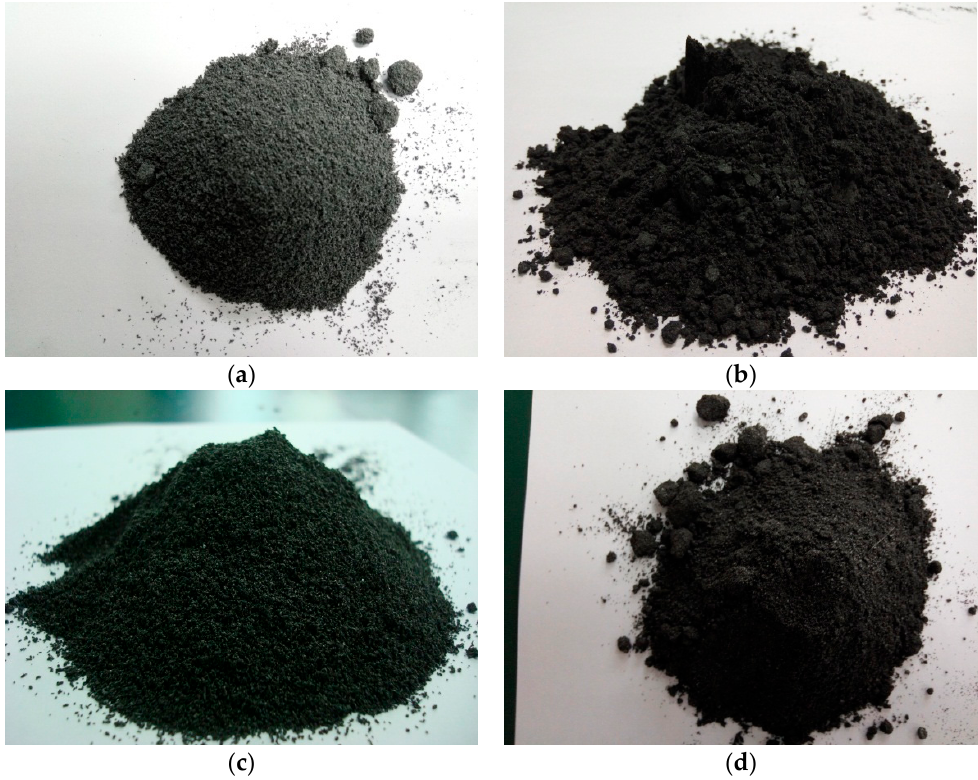
Figure 3. Appearance of the used materials in this study. ( a ) Expanded graphite (EG); ( b ) Graphene nanoplatelets (GNPs); ( c ) EG–paraffin CPCM; ( d ) GNPs–paraffin CPCM.